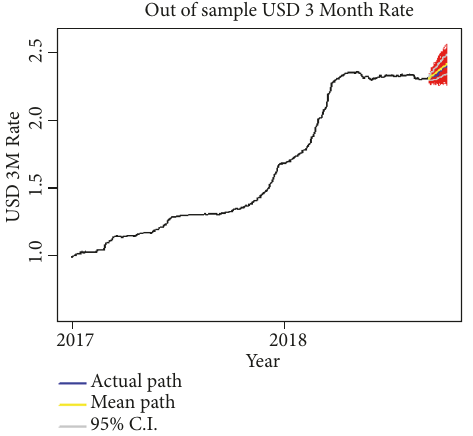
Figure 6: Visual Plot of the Simulated GBP 3M LIBOR. Table 3: Descriptive Statistics of the Simulated Overnight USD